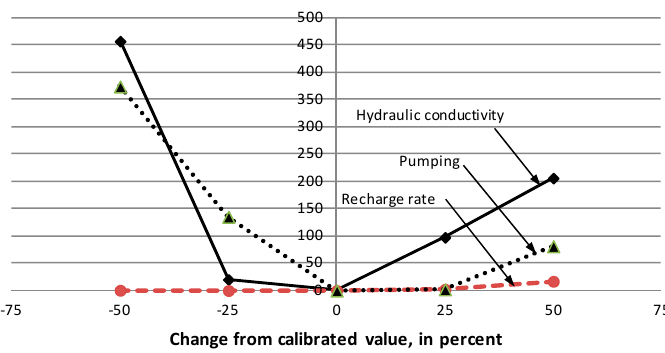
Figure 14. Sensitivity analysis of the parameters in the MODFLOW model.